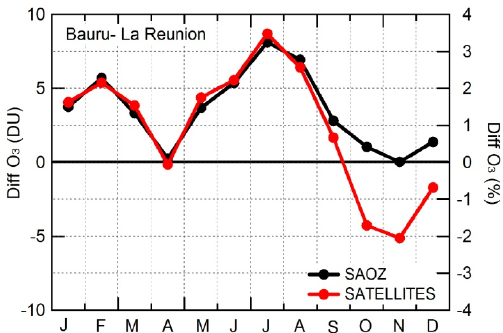
Figure 8. Seasonal cycle of the ozone difference between Bauru and Reunion for SAOZ (black) and merged satellite composite